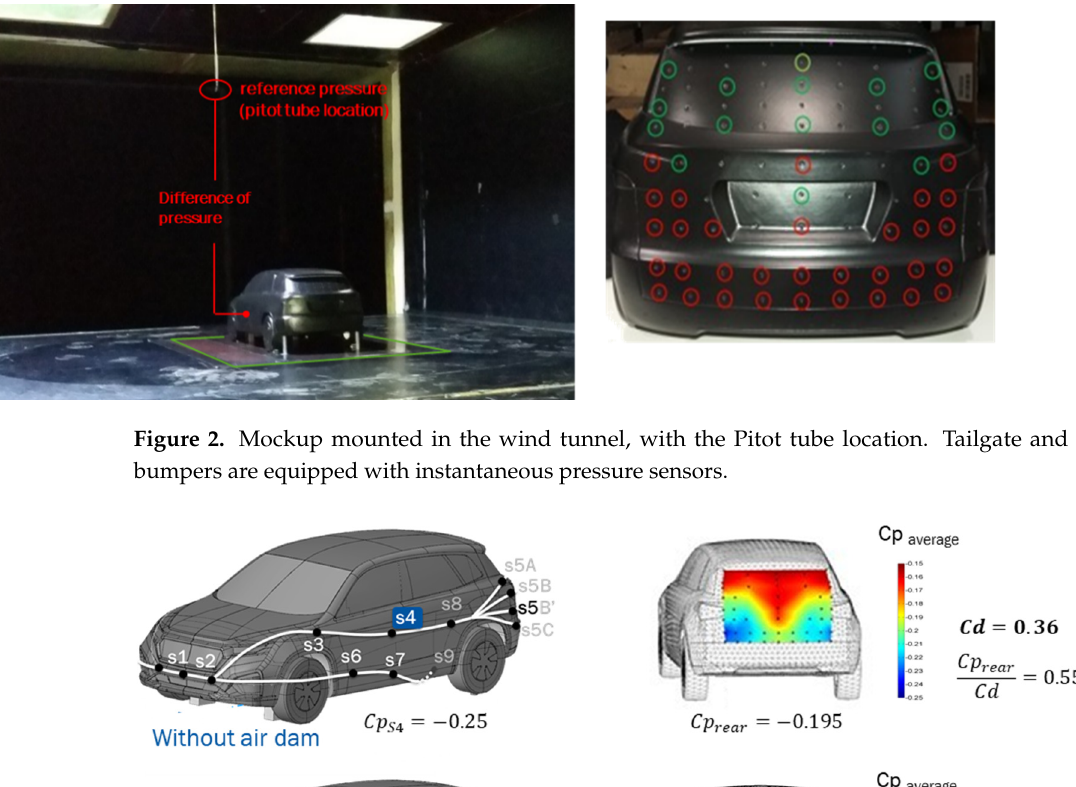
Figure 2. Mockup mounted in the wind tunnel, with the Pitot tube location. Tailgate and rear bump- ers are equipped with instantaneous pressure sensors.